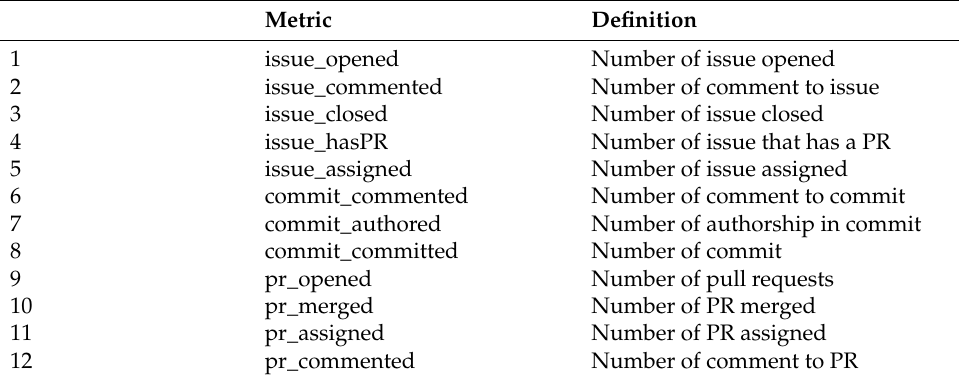
Table 8. Single developer metrics